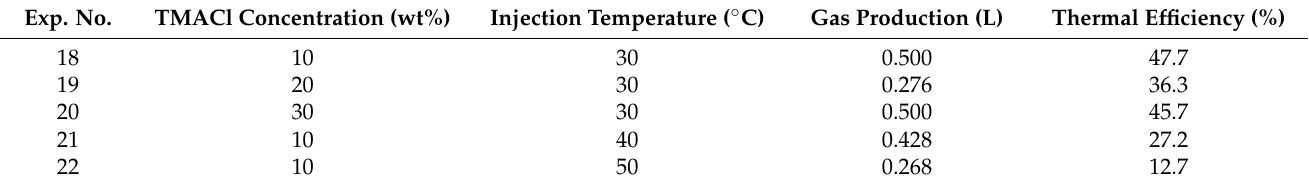
Table 5. The initial experimental conditions and results of CH 4 production by the injection of TMACl